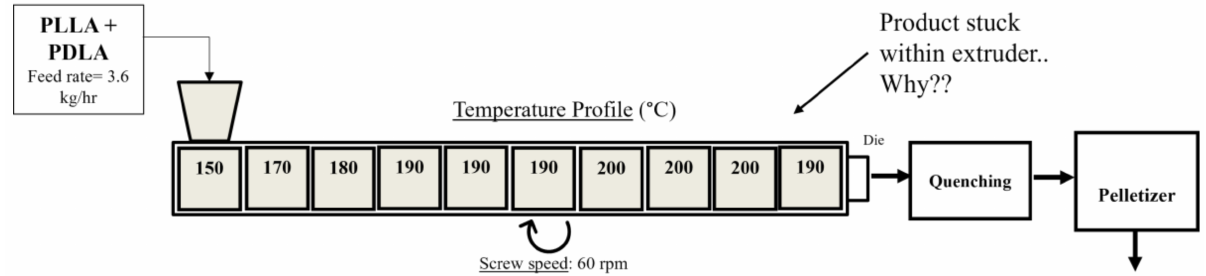
Figure 3. Processing conditions for the first trial run of stereocomplex PLA in a co-rotating twin-screw extruder type ZSE 27 HP–PH from Leistritz.